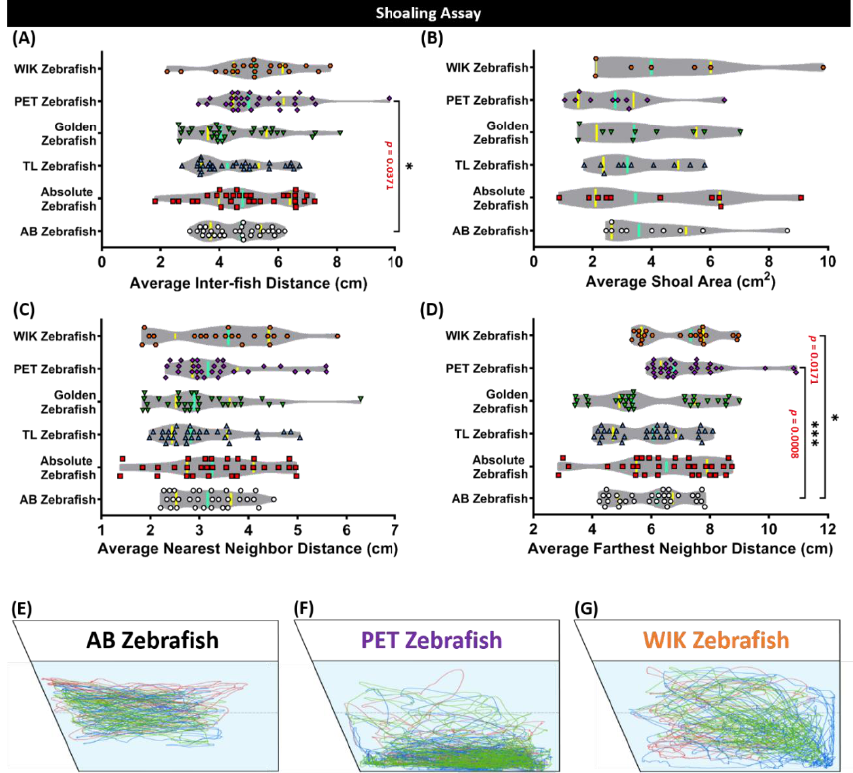
Figure 5. Shoaling endpoint comparisons between the AB strain zebrafish (white), absolute zebrafish (red), TL (Tübingen Long Fin) zebrafish (blue), golden zebrafish (green), PET (Pet Store-purchased) zebrafish (purple), and the WIK (Wild Indian Karyotype) zebrafish (orange). ( A ) Average inter-fish distance, ( B ) average shoal area, ( C ) average nearest neighbor distance, and ( D ) the average furthest neighbor distance were analyzed for the shoaling assay. Groups of three fish were tested for shoaling behavior. The median and the interquartile for the violin plot were labeled with the bold line colored with cyan and yellow, respectively. The 5 min locomotor trajectories for the AB, PET, and WIK zebrafish are presented in ( E – G) , respectively. The faint grey line indicates the borderline between the top and bottom portions of the test tank. The data were analyzed by a Mann–Whitney test ( n = 30 for each group, except for the WIK zebrafish ( n = 21); * p < 0.05; *** p < 0.001).